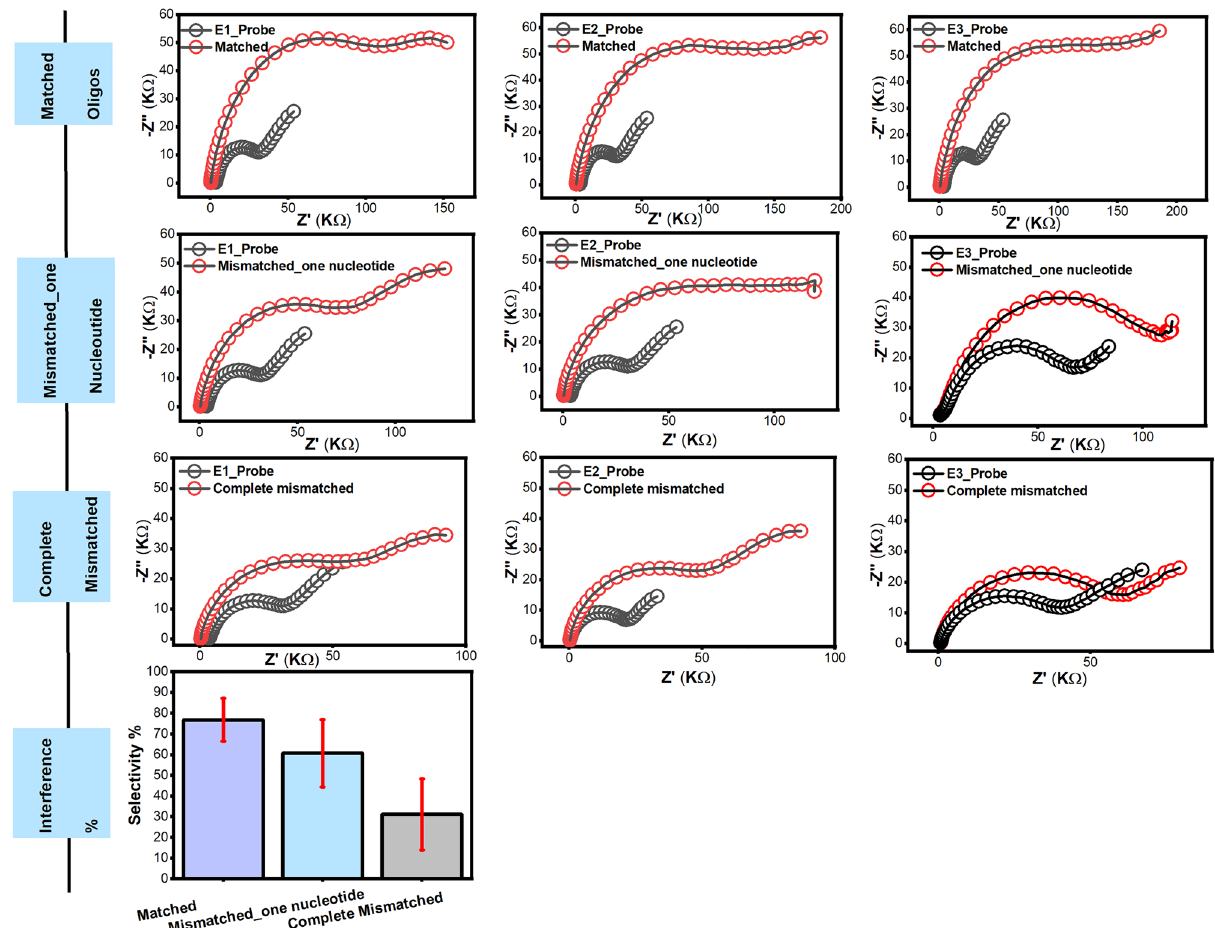
Figure 6. The impedimetric response of the fabricated SARS-CoV-2-RNA biosensor chips towards the mismatched designed Oligos (one nucleotide, completely mismatched), the chips were used in triplicates. The ΔRct was estimated and the percentage of the interference was obtained. The electrodes showed a response of 79% and 40.6%, respectively. The error bars expressed the standard deviations (SDs) between the three electrode